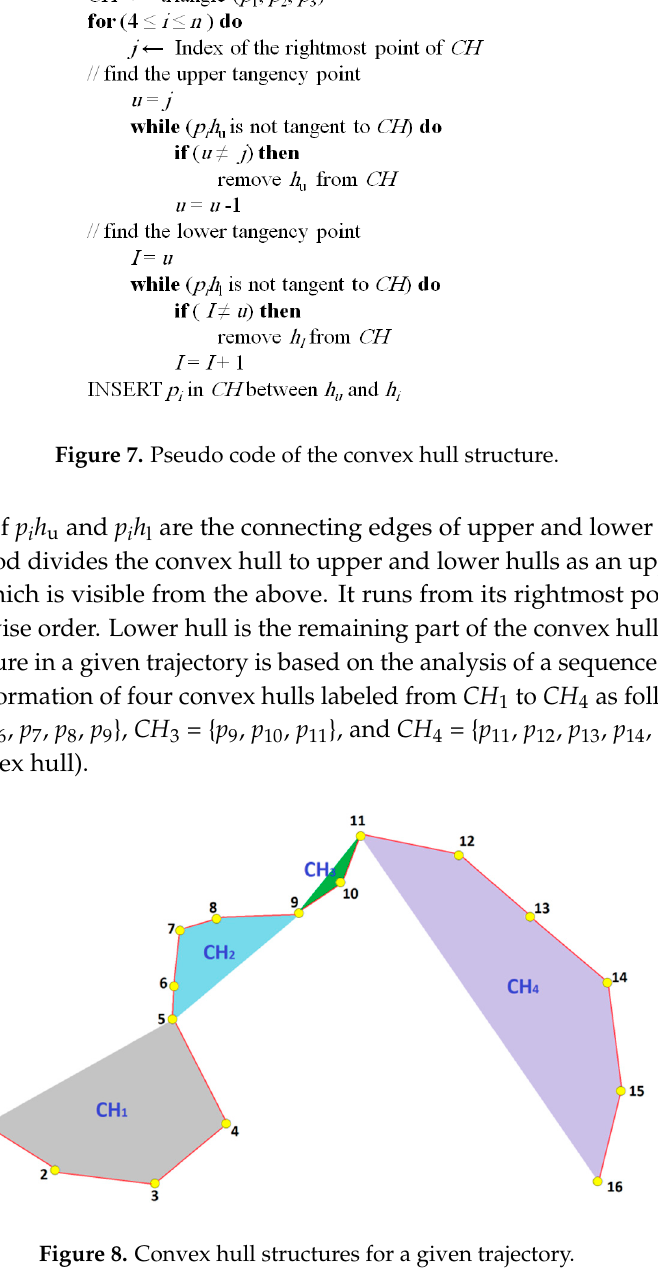
Figure 6. Two-dimensional (2D) convex hull structure for a given set of points.